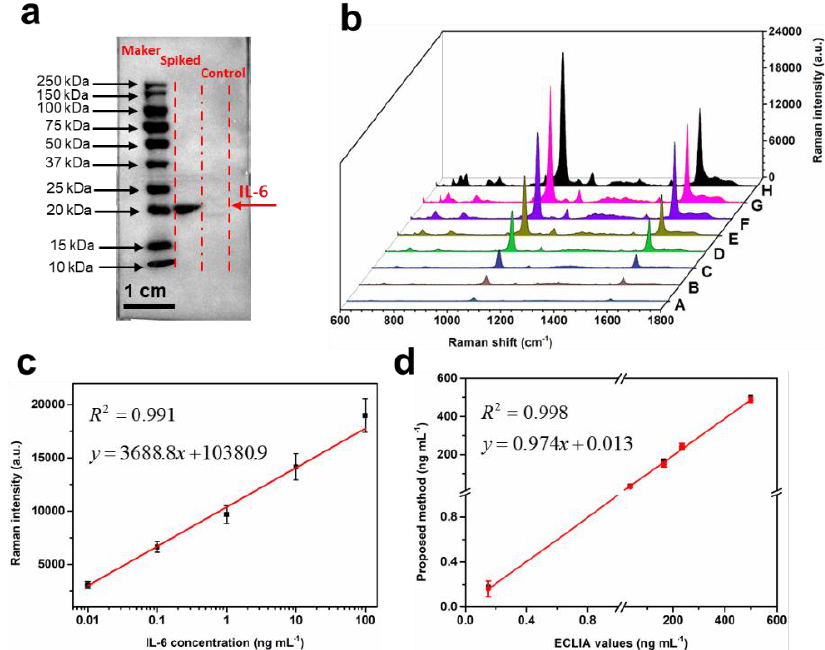
Figure 8. ( a ) Western blot analysis of IL-6 protein spiked in the milk; ( b ) SERS spectra of different concentrations (0 ng mL − 1 –1 µ g mL − 1 ) of IL-6 spiked in the milk and ( c ) the linear calibration curve; ( d ) comparison of detection results obtained from proposed method (red circles) and reference ECLIA method (black squares). Error bars are calculated from three measurements.